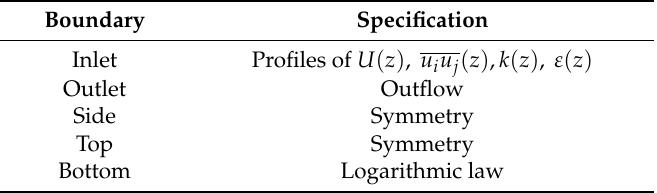
Table 1. Boundary conditions.